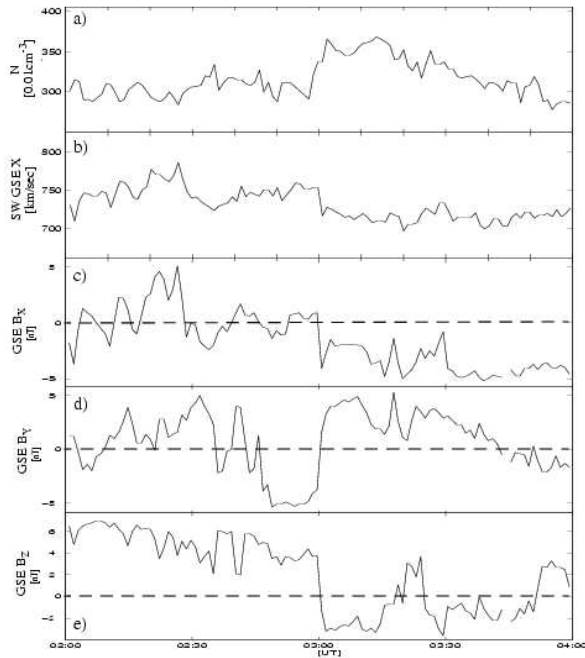
Fig. 2. Solar wind measurements by Geotail, 24 July 1998. From top to bottom the panels shows ( a ) particle density, ( b ) solar wind velocity in the GSM x -direction, and three components of the inter- planetary magnetic field, ( c ) B x , ( d ) B y and ( e ) B z . The coordinate system is